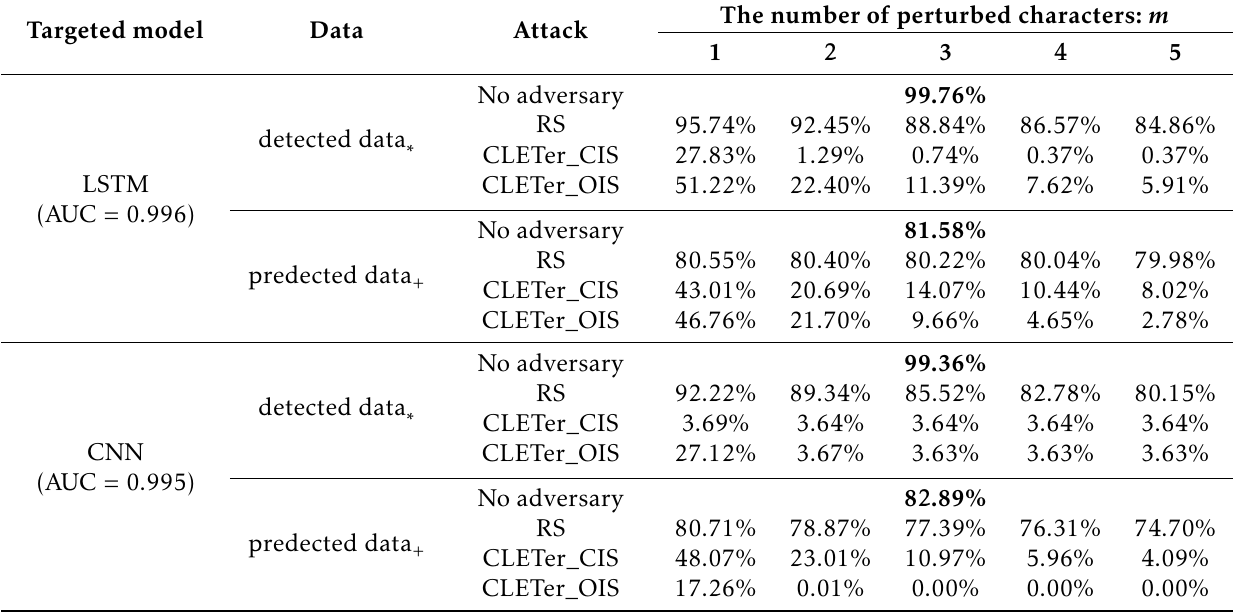
Table 3. The results of recalls for two targeted models